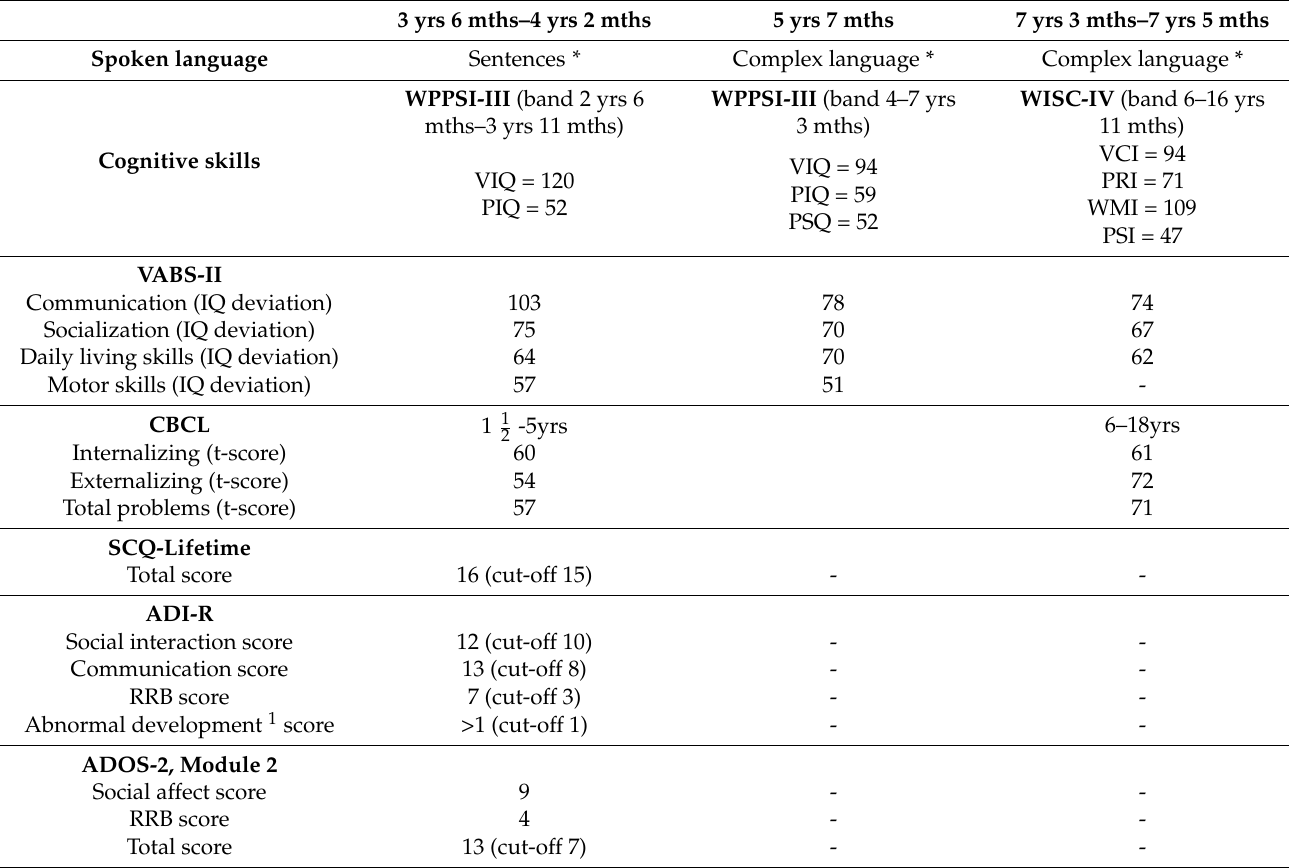
Table 2. Speech, Cognitive and Behavioural characteristics of the